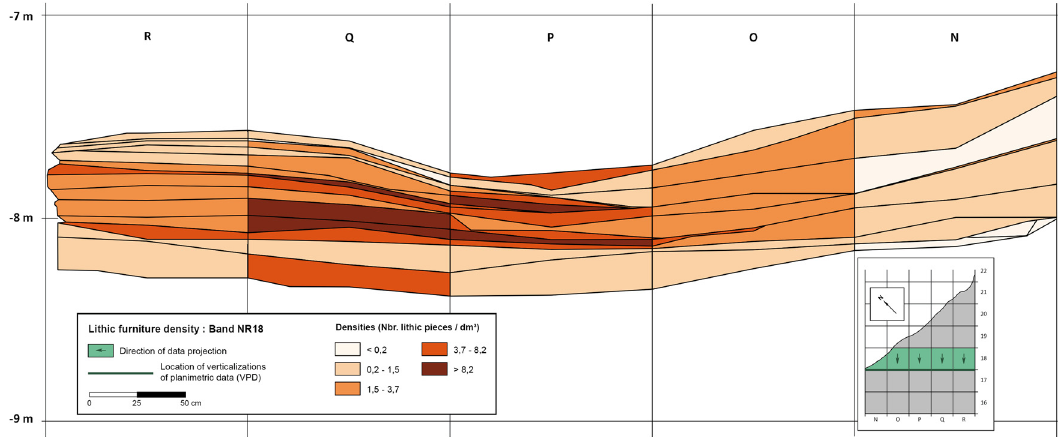
Figure 7: VPD on the NR18 axis displaying the density of lithic furniture for every square metre of each decapages ( from